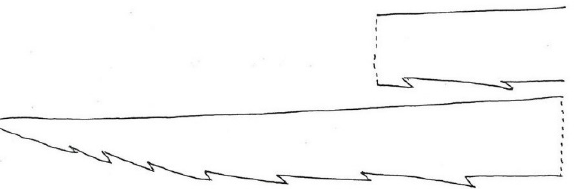
Figure 2. Terminal part of a sting lancet in the western honey Apis mellifera bee to illustrate the number and strength of the barbs. It has a very high serration index (defined in the text) of Sr = 2.43. Width at the dashed line is approximately 0.04 mm.